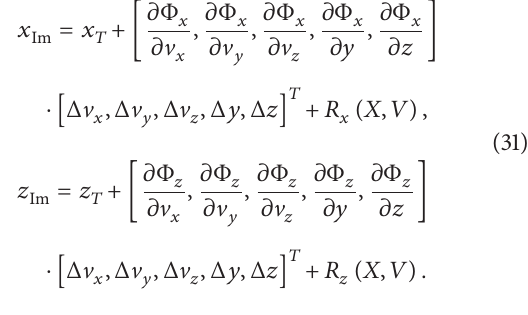
(𝑥 , 𝑦 , 𝑧 ) are the positions of 𝑇 𝑇 𝑇 𝑇